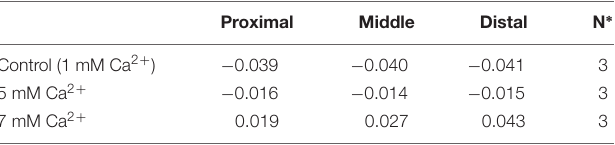
TABLE 2 | (cid:49) Fluorescence/Minute Mean with varying [Ca 2 +